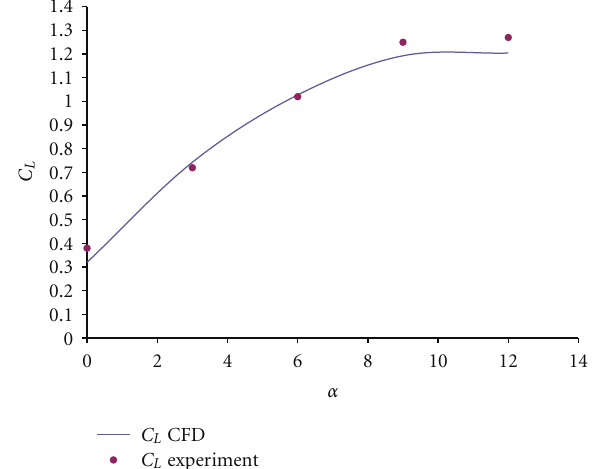
Figure 4: Comparison of C L Versus α of CFD simulation results with NREL experimental